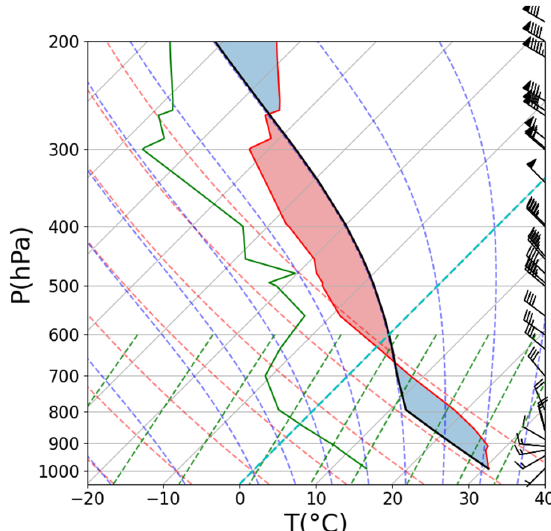
Figure 3. Skew-T log-P diagram based on the weather balloon sounding in Beijing, at 12:00 UTC 31 May 2017. The black solid line shows the state curve, the red solid line shows the atmospheric stratification curve, the green solid line the ambient dew shows point temperature curve, the red dashed line represents the dry adiabatic line, the blue dashed line represents the wet adiabatic line, and the green dashed line represents the saturation mixing ratio line.